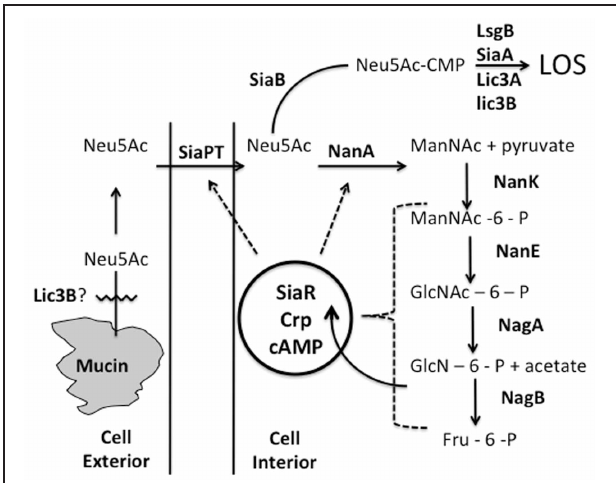
FIGURE 2 | A composite model of Neu5Ac uptake, incorporation into LOS and catabolism into the Krebs cycle is shown. The different steps in the process is described in